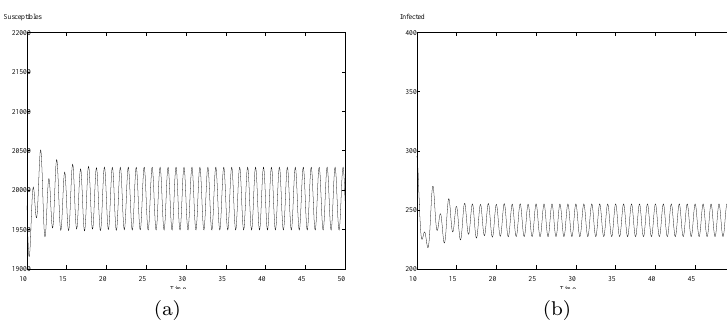
Figure 2. One year periodic solution of our model and plots approximate results of ( a ) the susceptibles S ( t ) and ( b ) the infected I ( t ) against time in years, when ( R 0 > 1 ).